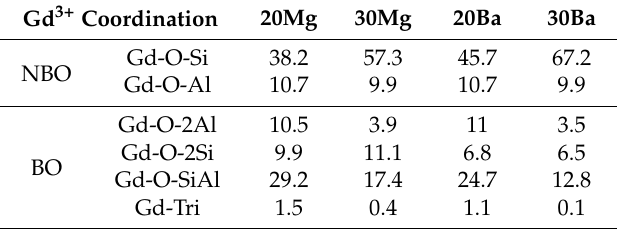
Table 7. Fractions [%] of bridging (BO) and non-bridging oxygen (NBO) atoms within the first coordination shell of Gd 3+ separated according to the second-nearest